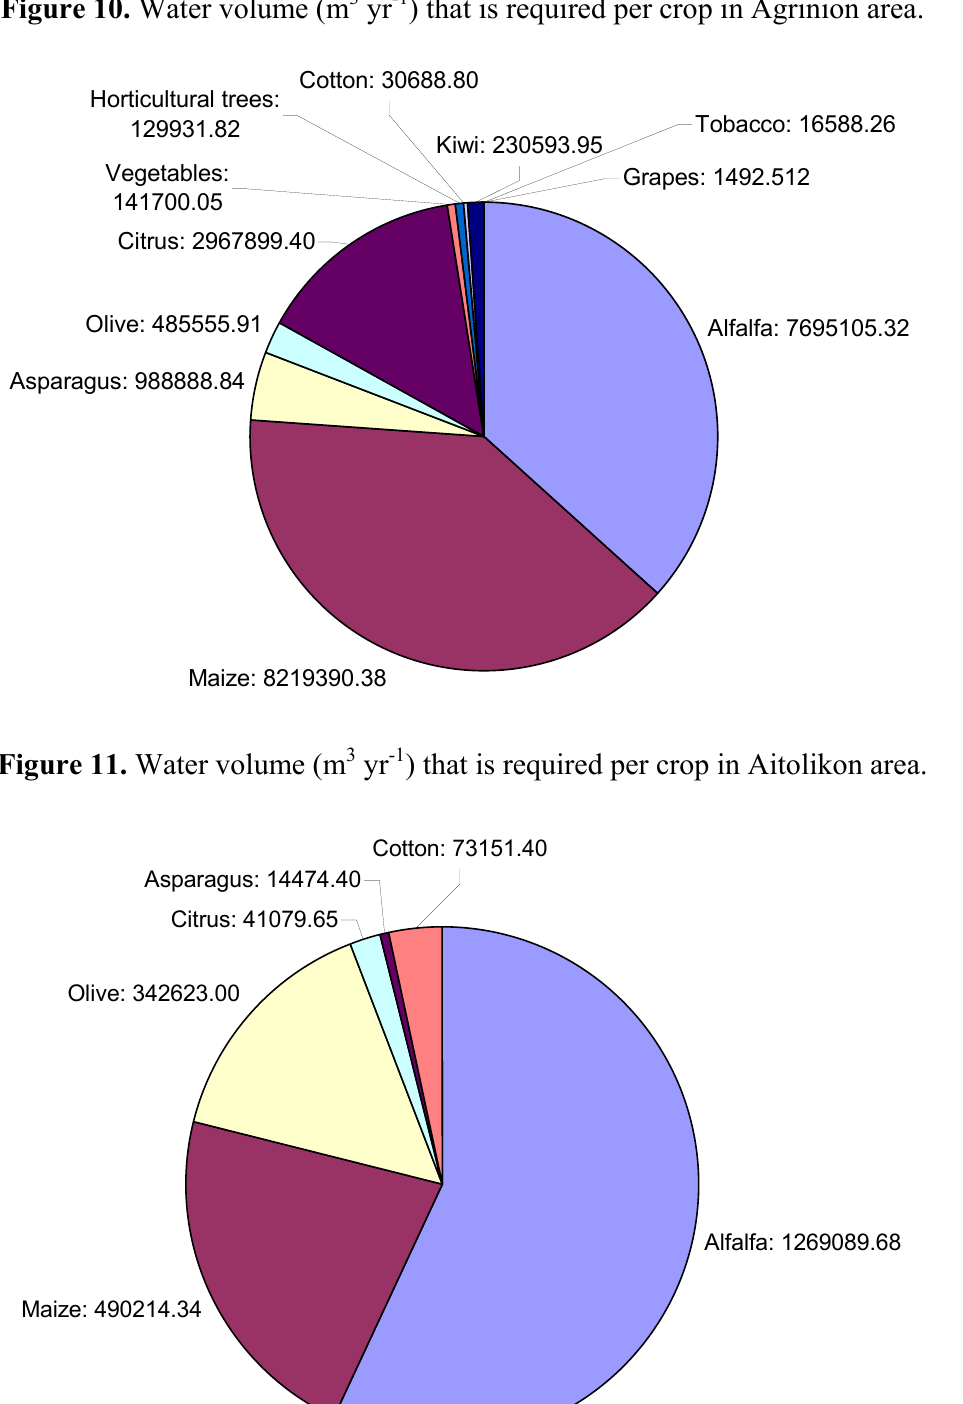
Figure 10. Water volume (m 3 yr -1 ) that is required per crop in Agrinion area.